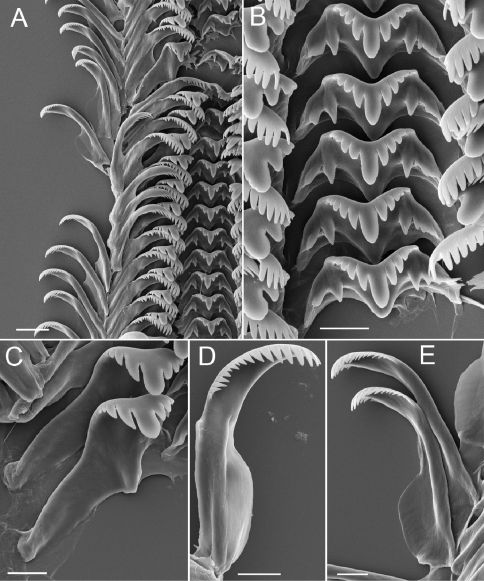
Radula, Marstonia comalensis, USNM 874926. A Portion of radular ribbon B Central teeth C Lateral teeth D Inner marginal tooth E Outer marginal teeth. Scale bars A, 20 µm; B-E, 10 µm.